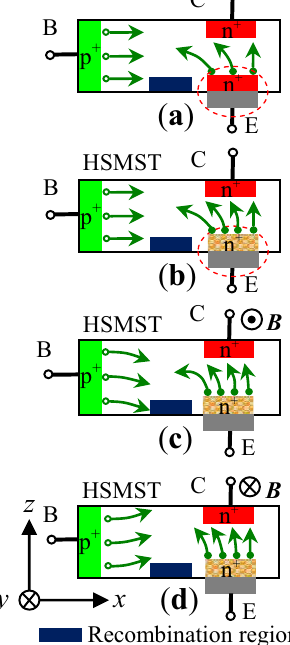
Figure 3. The working principle of the magnetically sensitive transistor (MST) under different B : ( a ) B = 0 T; ( b ) B = 0 T; ( c ) B > 0 T; ( d ) B < 0 T. B: base; C: collector; E: